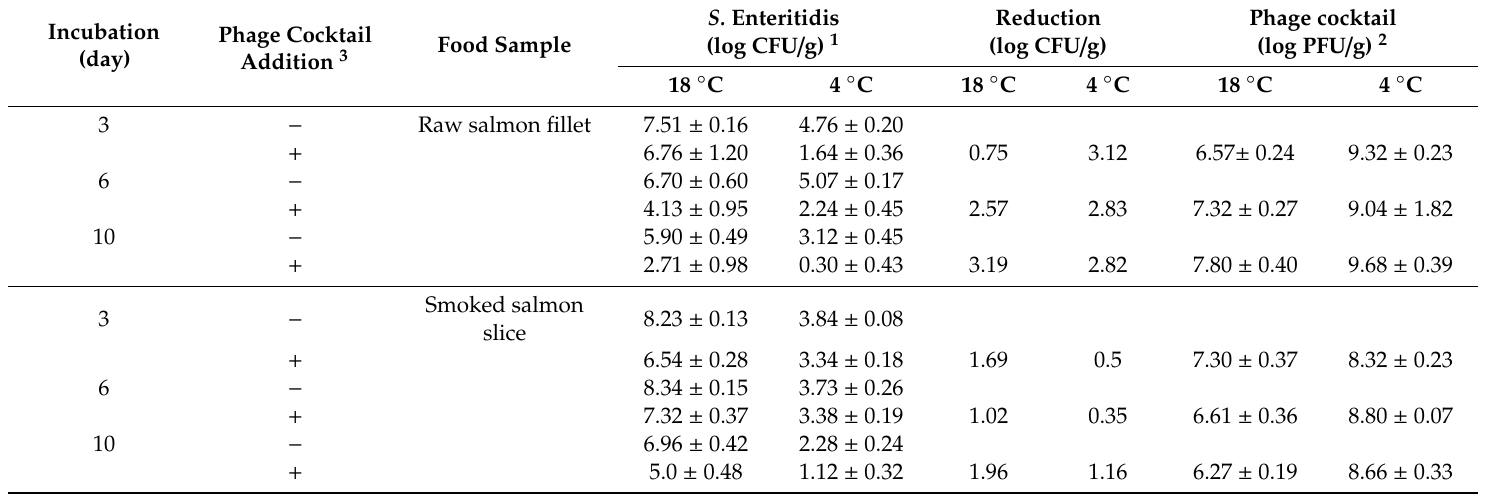
Table 3. E ffi cacy of the bacteriophage cocktail in the reduction of Salmonella Enteritidis in raw salmon fillets and smoked salmon